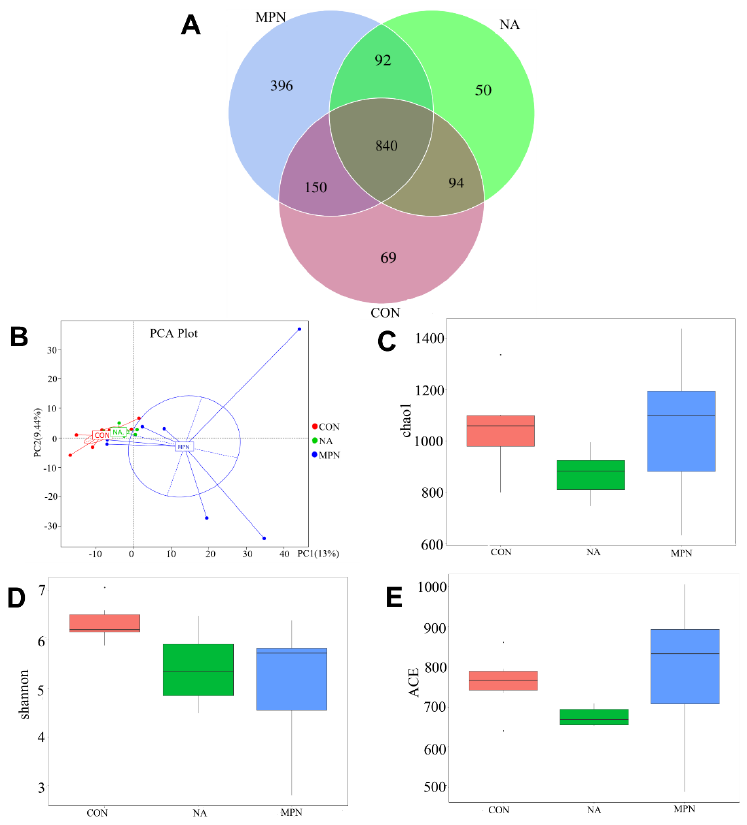
Figure 4. Effect of niacin on colonic microbial communities in weaned piglets. Venn diagram of OTU ( A ), PCA ( B ), Chao 1 index ( C ), Shannon index ( D ), and ACE index ( E ) showing the α- and β-diversity of colonic microbiota. CON, control group; NA, niacin group; MPN, GPR109A antagonist group.